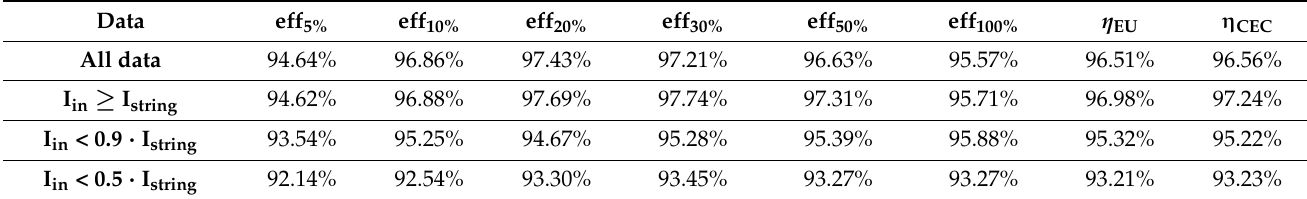
Table 1. SDPO efficiency calculations for different Iin/Istring.